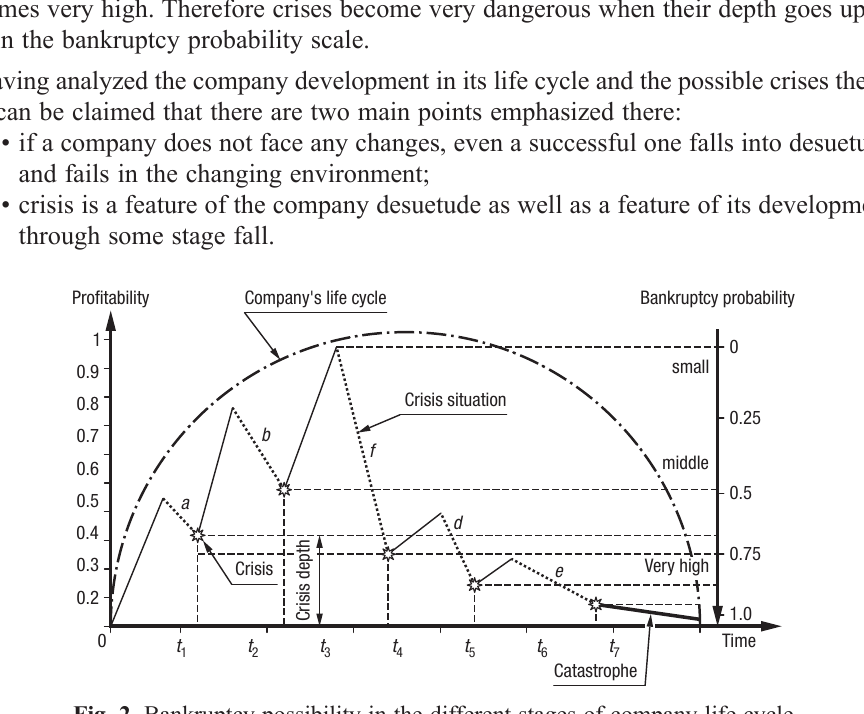
Fig. 2. Bankruptcy possibility in the different stages of company life cycle (designed by the